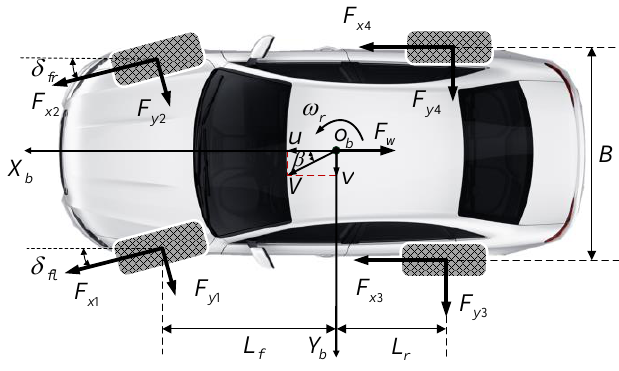
Figure 4. Vehicle body dynamic model.